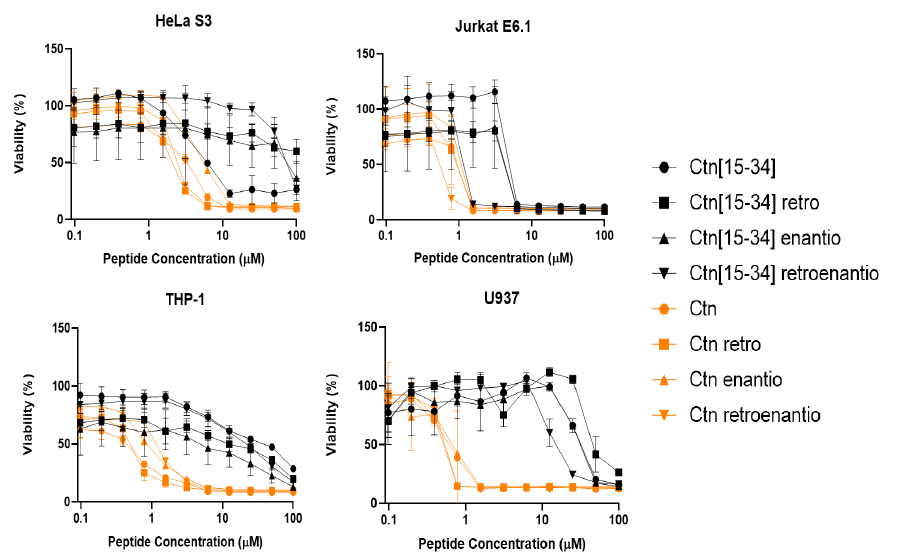
Figure 1. Viability of leukemia cells upon peptide treatment for 24 h. Ctn[15-34] and Ctn topoisomers are depicted in black and orange, respectively. Results are the average of three replicates.